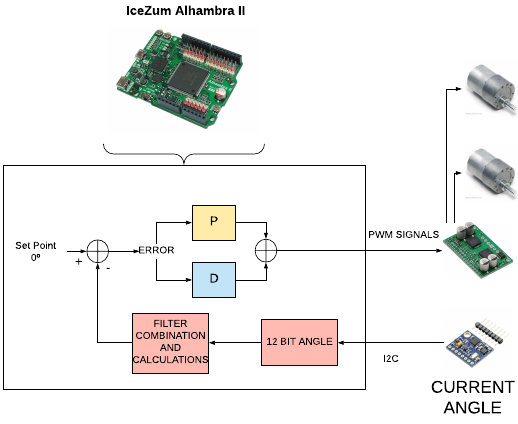
Figure21. Hardwaredesignoftheinvertedpendulumcontrolwithoutmicrocontroller. Figure 21. Hardware design of the inverted pendulum control without